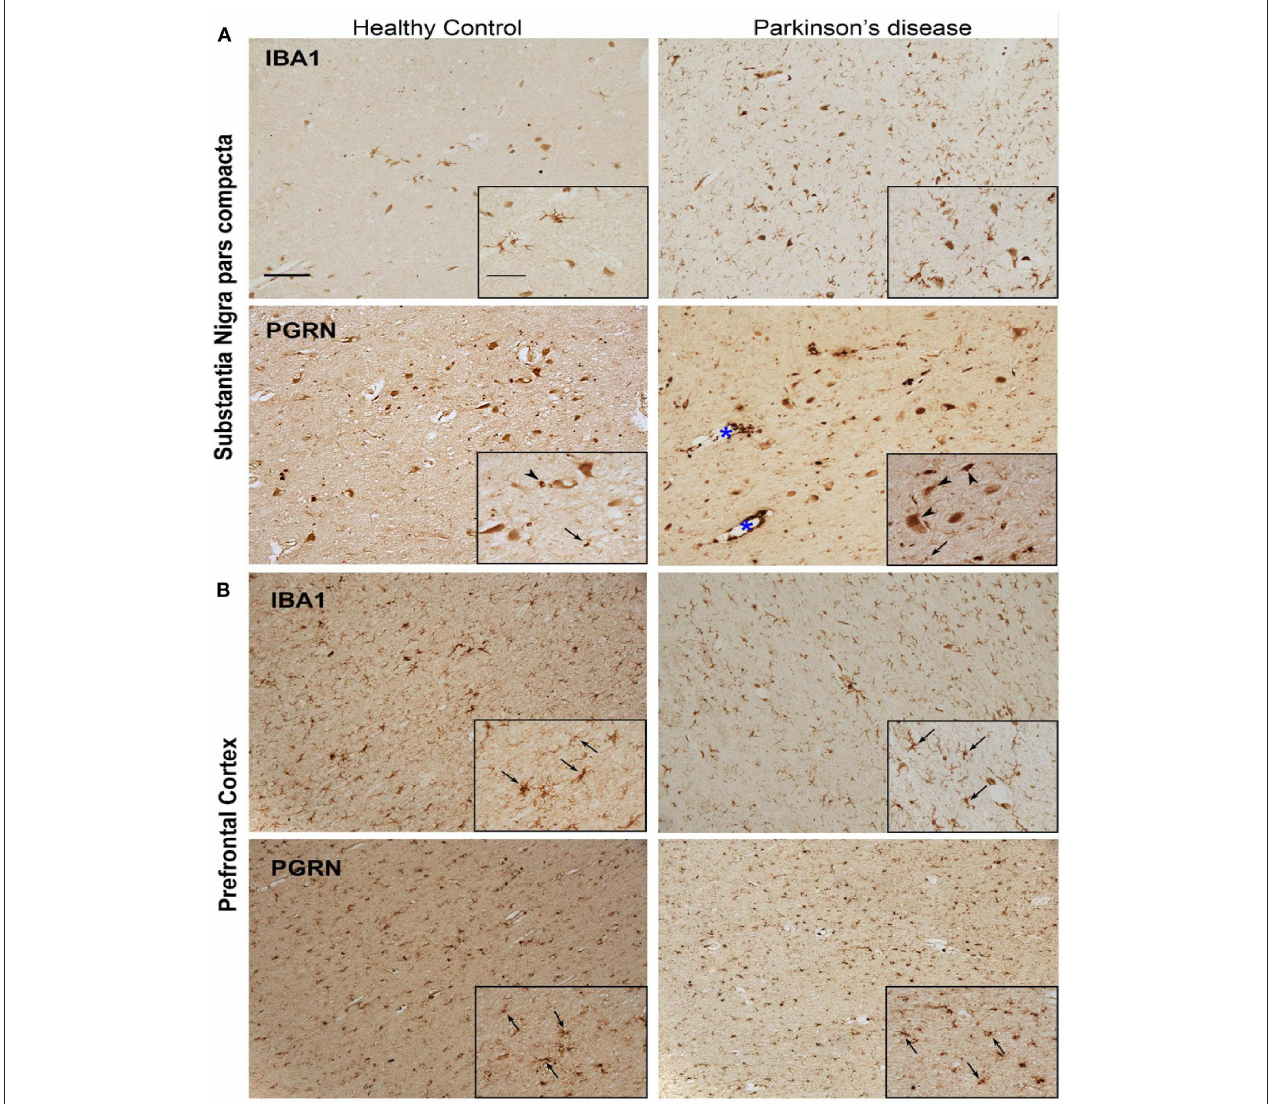
FIGURE 5 | Representative microphotographs of IBA1 and PGRN immunostained tissue in the region of the SNpc (A) and PFC (B) of a healthy control and PD patient. Presence of IBA1 + microglia significantly increased in the nigra of PD compared to healthy control, yet despite the abundant quantity of microglia, few PGRN-immunoreactive cells resemble microglia morphology (arrows) in the SNpc (A) . Instead, PGRN is detected in neuromelanin cells or present as neuronal cell bodies (arrow heads) and in perivasculature spaces (blue asterisk). IBA1-immunoreactivity is similar in the PFC between healthy control and PD patient, and PGRN + cells largely resemble microglial morphology (arrows) in both subjects (B) . Scale bar 100 µ m, inset 50 µ